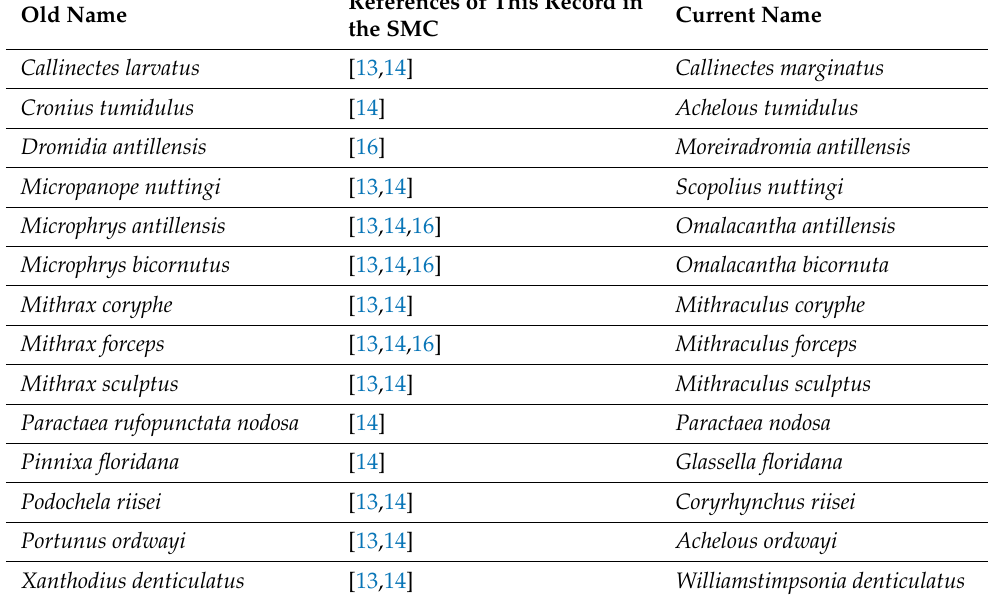
Table 1. Update of the species names of Brachyura and Achelata found in the bibliographic review. SMC = Southern Mexican